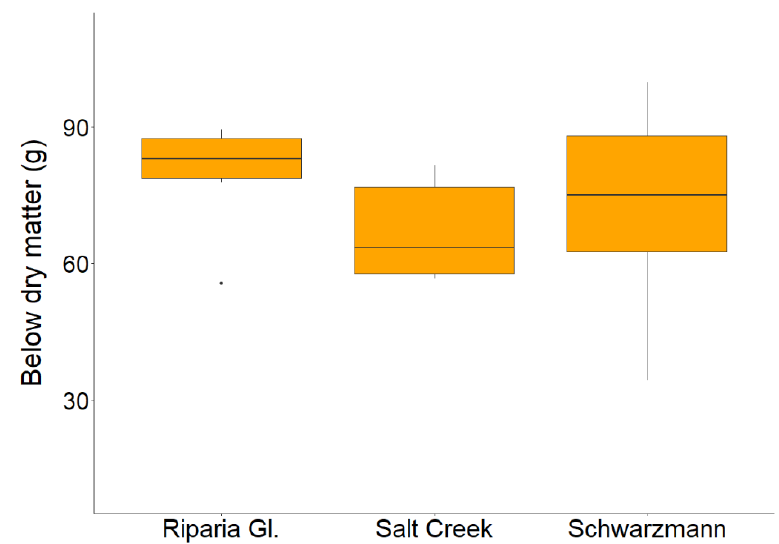
cultivation. Letters above boxes indicate significant differences at p < 0.05.